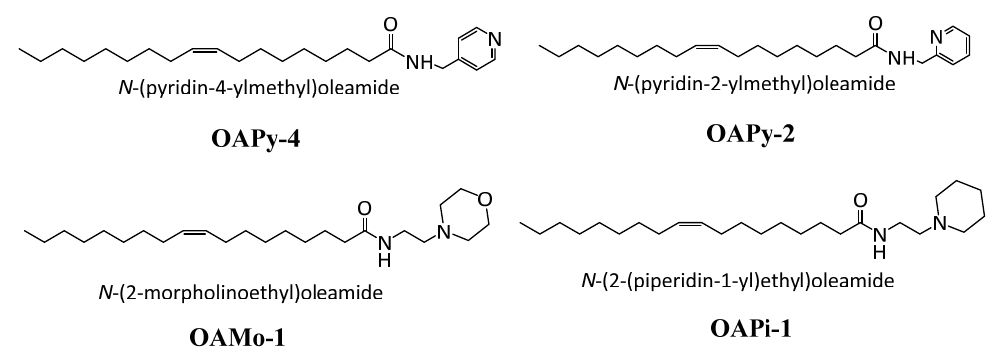
Figure 2. The chemical structure of amide ionisable aminolipids synthesised by employing a coupling reaction between the oleic acid and primary amines.